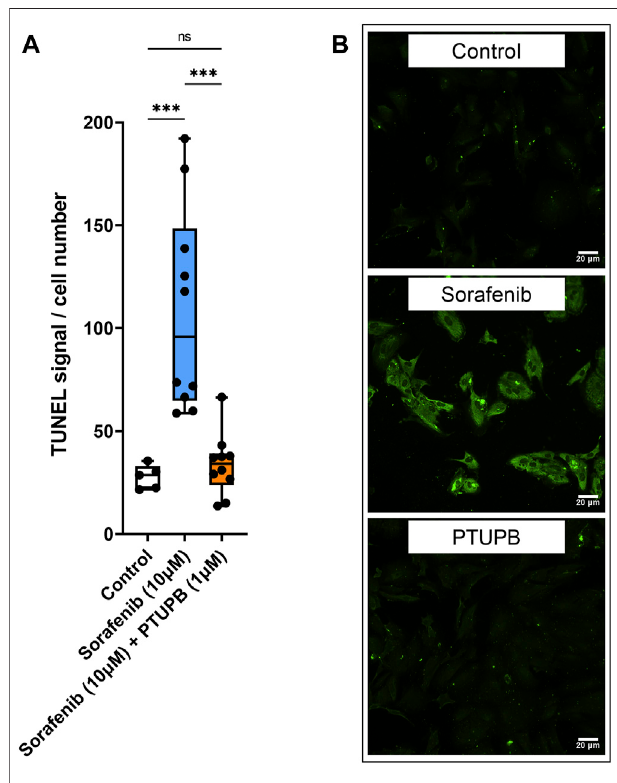
FIGURE 7 | Apoptosis. PTUPB decreased sorafenib-induced apoptosis. Sorafenib treatment elevated apoptotic signal in mesangial cells (orange bar). PTUPB mitigated apoptotic signal in mesangial cells (blue bar) (A) . Representative images of TUNEL staining at × 200 (TUNEL signal in green) ( n (cid:1) 5 – 10, dots represent the average of duplicate measures for each well). ns p > 0.05, *** p ≤ 0.001 determined by ANOVA followed by the Tukey post-hoc test. Data are reported as a box and whisker plot with median, minimum to maximum, and 10 to 90